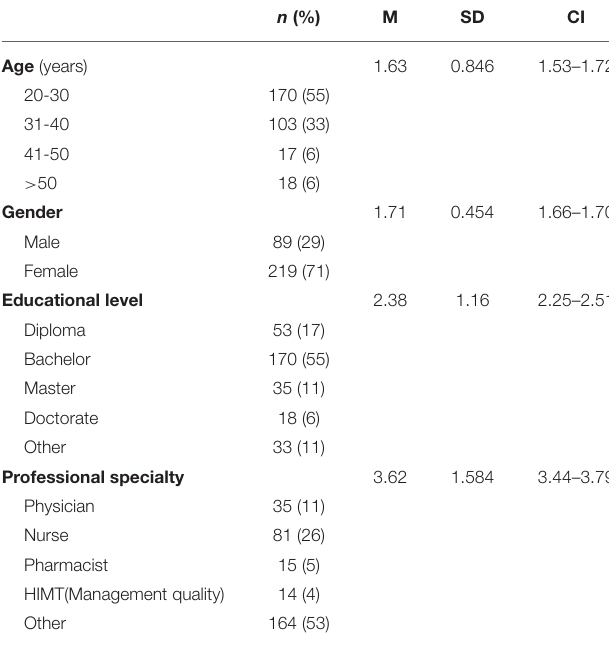
TABLE 1 | Demographic information of the participants ( n = 308).